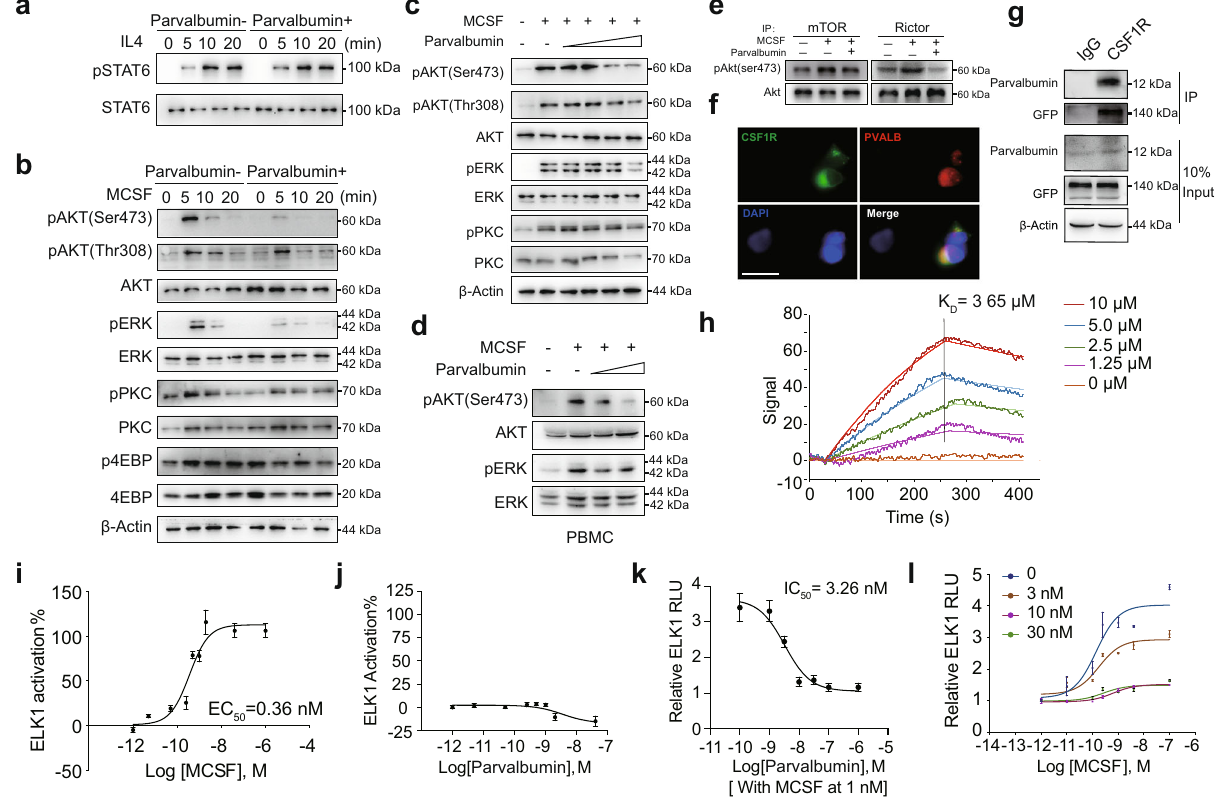
Fig. 3 Parvalbumin functions as a CSF1R antagonist to inhibit M2 macrophages. a Representative immunoblots showing effects of parvalbumin (100ng/ml) treatment on IL4-induced STAT6 phosphorylation at indicated time in BMDMs. b Representative immunoblots showing effects of parvalbumin (100ng/ml) treatment on MCSF-induced mTORC2 downstream targets and ERK activation at indicated time in BMDMs. Representative immunoblots showing effects of varying concentrations of parvalbumin treatment on MCSF-induced mTORC2 downstream targets and ERK activation in BMDMs (concentrations of parvalbumin: 10ng/ml, 50ng/ml, 100ng/ml, 200ng/ml) ( c ) and human PBMCs (concentrations of parvalbumin:10ng/ml, 100ng/ml) ( d ). e examination of mTORC2 activity through in vitro kinase assay. f Co-localization of parvalbumin with transiently transfected CSF1R in COS7 cells. Scale bar, 20 μ m. g Interaction between parvalbumin and immunoprecipitated GFP-tagged CSF1R. h Measurement of the binding af fi nity between parvalbumin and CSF1R proteins by SPR method. i Concentration-response curve of MCSF on CSF1R activation detected by ELK1-Luc in cells stably expressing CSF1R (MCSF EC50 = 0.36±0.03nM, n = 3 per group). j Concentration-response curve of parvalbumin on ELK1-Luc, showing that parvalbumin alone does not activate CSF1R ( n = 3 per group). k Concentration- response curve of parvalbumin on CSF1R activation in the presence of MCSF (parvalbumin IC50 = 3.26±0.06nM) ( n = 3 per group). l Concentration-response curve of parvalbumin on CSF1R activation in the presence of increasing concentrations of parvalbumin, showing that parvalbumin is a noncompetitive antagonist of CSF1R ( n = 3 per group). Data are represented as mean±SEM. Source data are provided as a Source Data fi in vitro kinase assay to directly test the in fl uence of parvalbumin on mTORC2 activity. MCSF-induced phosphorylation of puri fi ed AKT at Ser473 by mTORC2 was reduced by parvalbumin (Fig. 3e). At the meantime, MCSF-induced ERK (Thr202/Tyr204) phosphorylation was also inhibited by parvalbumin treatment in both BMDMs and PBMCs (Fig. 3c, d), indicating that parval- bumin may target the MCSF receptor (CSF1R) to in fl uence its downstream signaling. To test this possibility, we transfected COS-7 cells with CSF1R-GFP and then evaluated parvalbumin binding to these cells using fl uorescent-labeled parvalbumin. We found that parvalbumin bound to CSF1R-expressing cells, but not non-expressing cells, indicating speci fi c binding of parvalbumin with CSF1R (Fig. 3f). Indeed, by pull-down experiments, the interaction between exogenously expressed CSF1R and parval- bumin was con fi rmed in HEK293T cells (Fig. 3g). To further measure the binding af fi nity between parvalbumin and CSF1R, we employed a Surface Plasmon Resonance (SPR) assay and obtained a KD value of 3.65 μ M for these two proteins interaction (Fig. 3h). Based on these fi ndings, we hypothesized that parval- bumin might function as an endogenous antagonist of CSF1R.